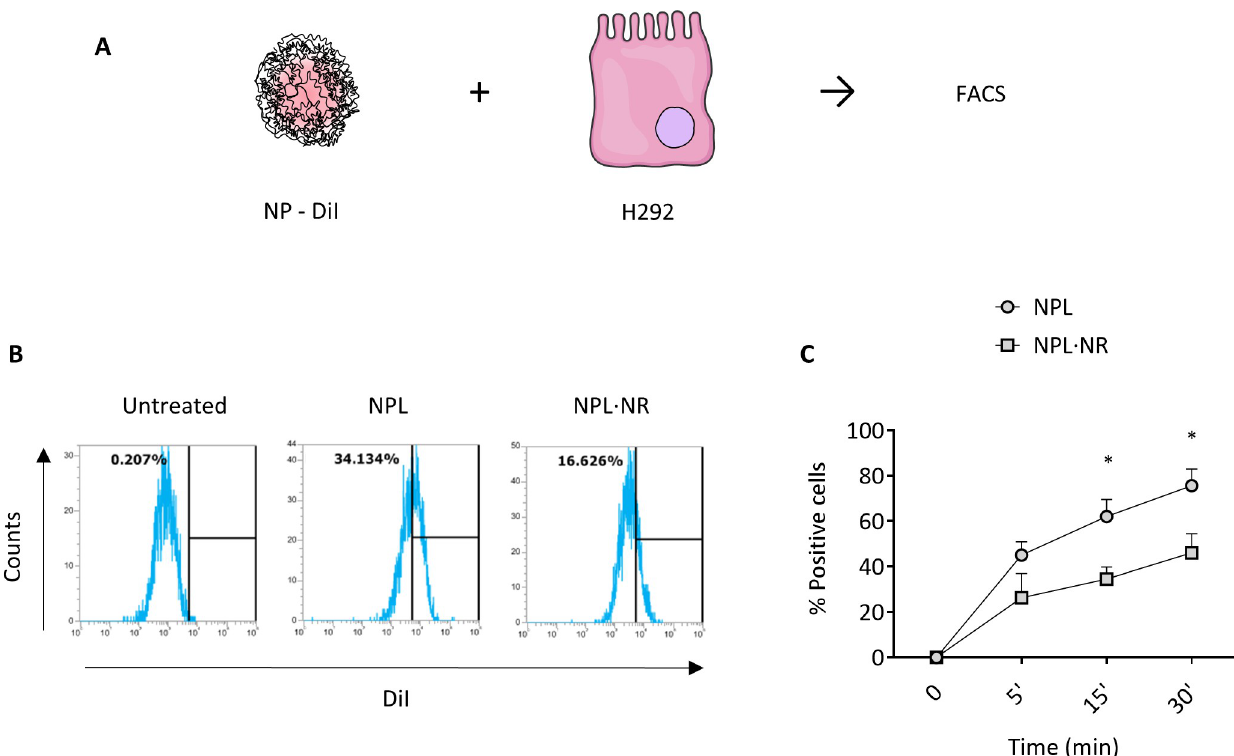
Fig 4. DiI-NPs were incubated with epithelial cells for 5 to 30 minutes (A). Their endocytosis on H292 cells was evaluated by flow cytometry (B & C). The results represent the mean ± SEM of at least 3 independent experiments, and the statistical comparison were made by ANOVA tests. �� p < 0.01, ��� p <